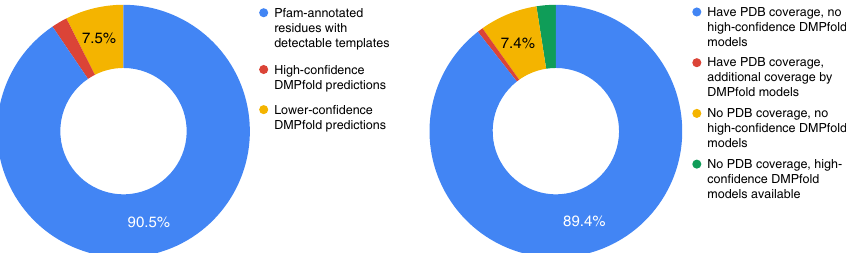
Fig. 7 Coverage of proteomes by DMPfold models. Left: Pie chart showing the fraction of Pfam-annotated amino acid residues in a number of proteomes for which templates or PDB matches are available (blue). Of the remaining residues, the fractions covered by high-con fi dence DMPfold models (red) and lower-con fi dence models (orange) are marked. Right: Pie chart of UniProt entries in several proteomes. Entries are fi rst split into whether or not they are (at least partially) covered by PDB matches or templates. Within each split, we then assess the fraction of entries that either have or do not have high- con fi dence DMPfold models available. The green fraction indicates entries for which de novo models provide the only structural information currently available. Data for each fraction of each pie chart are summed over several proteomes (full data in Supplementary Tables 2 and 3)